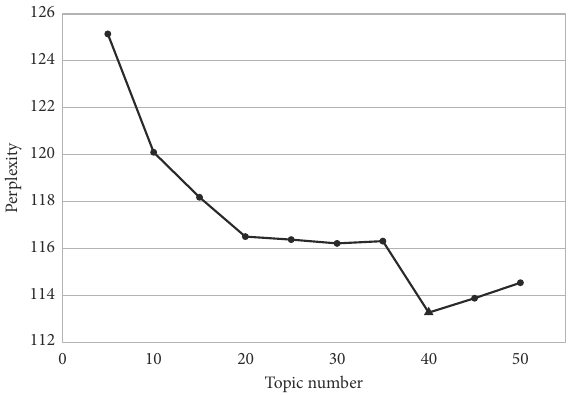
CPMs. Figure 4. Perplexity results of models with